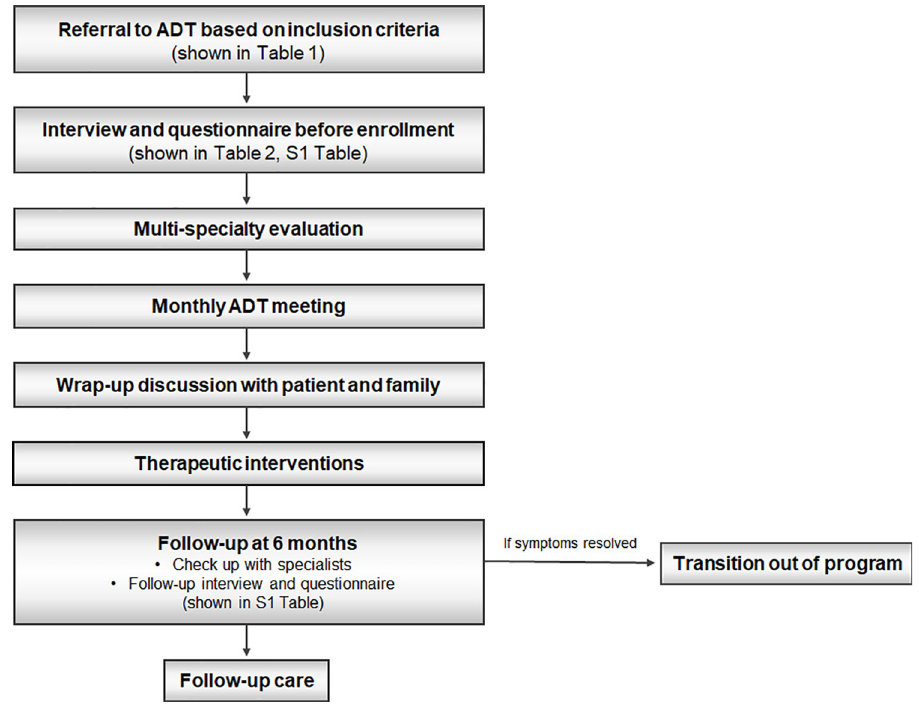
Fig 1. The study general algorithm. Abbreviations: ADT, AeroDigestive